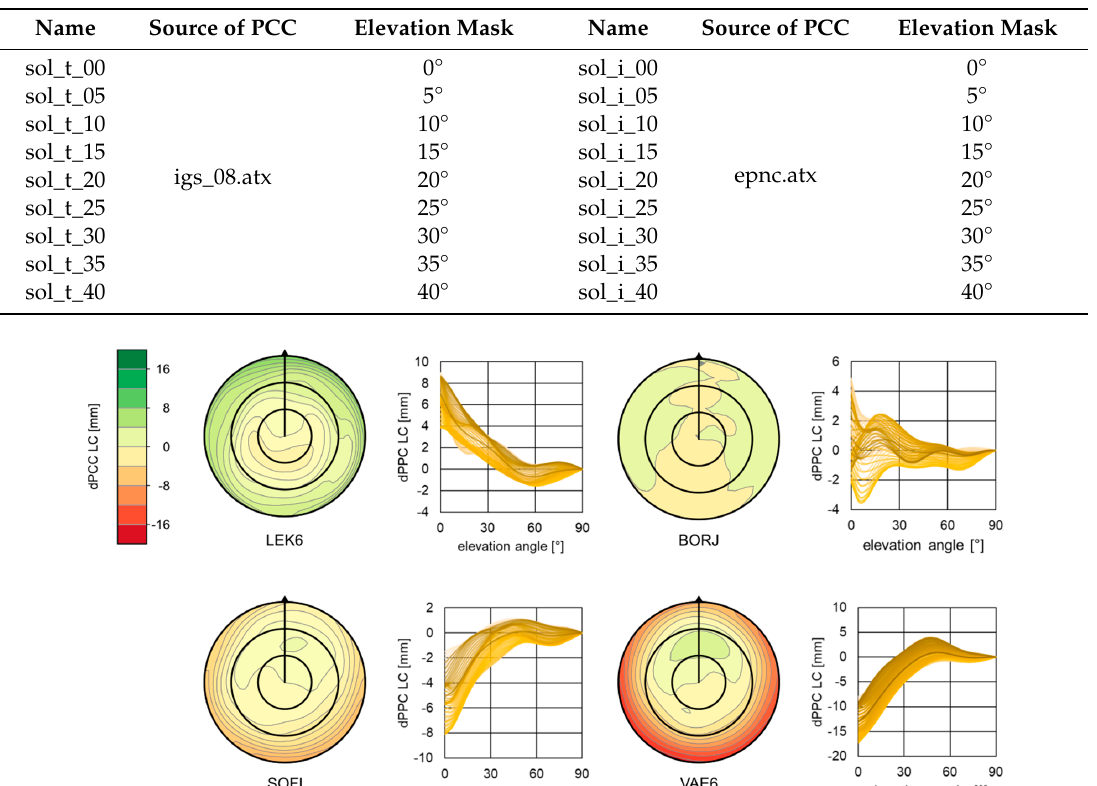
Table 1. Solutions prepared in this study. PCC—phase center correction.